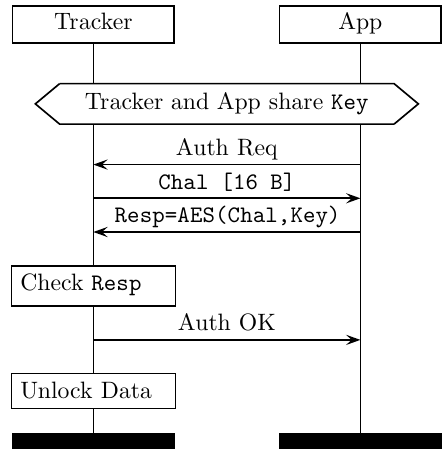
Figure 5: Xiaomi Authentication. Using a challenge-response procedure, the tracker unilaterally authenticates that the app owns the shared pairing key ( Key ). the newest releases (i.e., MB 6) and the most recent app versions. We now describe the vulnerabilities grouped by